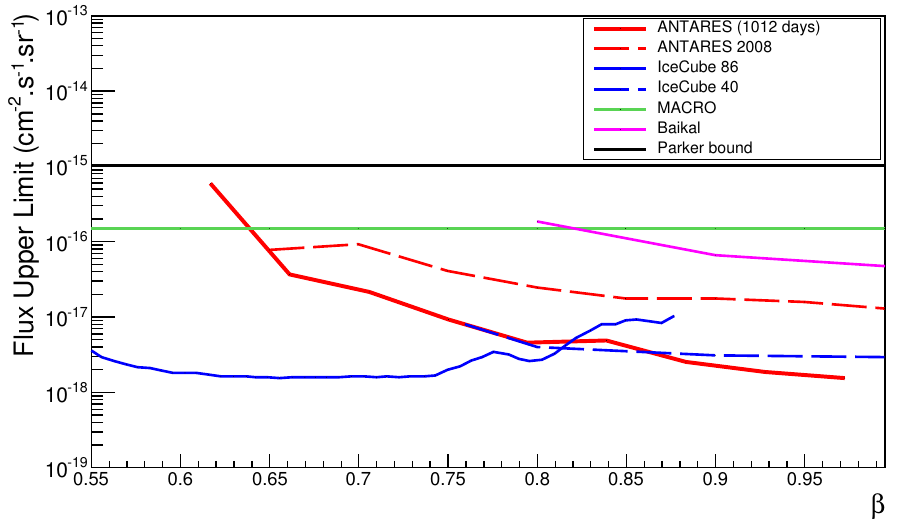
Figure 8 . ANTARES 90% C.L. upper limit on (cid:13)ux for MMs using (cid:12)ve years of data with 1012 active days live time (solid red line), compared to the upper limits obtained by other experi- ments [18, 42, 43], as well as the previous analysis of ANTARES (dashed red line) [17] and the theoretical Parker bound [15]. In [18] a more optimistic model for (cid:14) -rays production of MMs is used, making a direct comparison